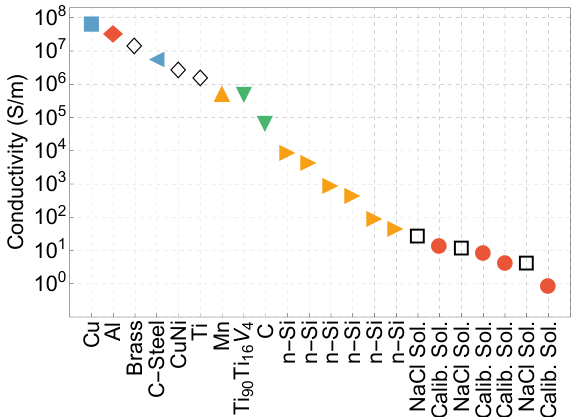
Figure 4. Development, in terms of sensitivity, of EMI-AM systems from the first proof-of-concept in 2014 to the latest results in 2020. The horizontal axis reports the materials used for the different demonstrations. Filled symbols represent results in unshielded environment, while open symbols indicate measurements in shielded environment. Filled diamonds data are from Ref. [26], filled square from [29], open diamonds from [30], filled triangle up from [22], filled triangle down from [40], filled triangle left from [41], filled triangle right [35], open squares from [36], closed disks from